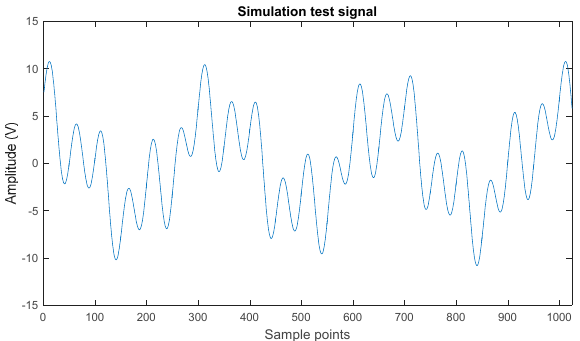
Figure 2. Test simulation signal with the specified frequency component.